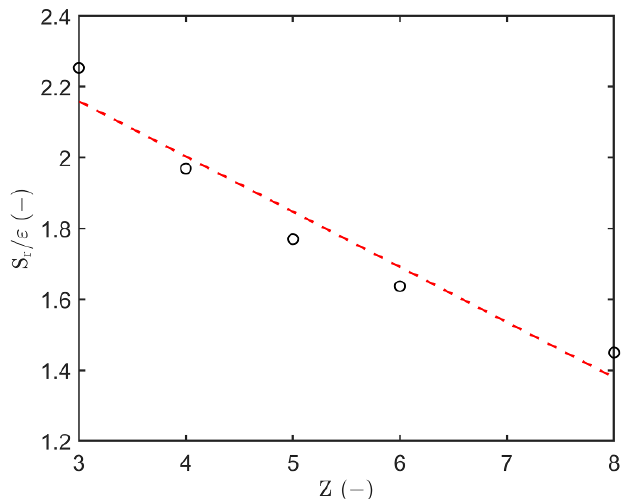
Figure 5. The function S r / ε against pore connectivity at constant σ 0 / r = 25 / 250 ( µ m). The connectivity presents the average of whole pore connectivity for the whole network. Simulated values have been averaged over 40 realizations.